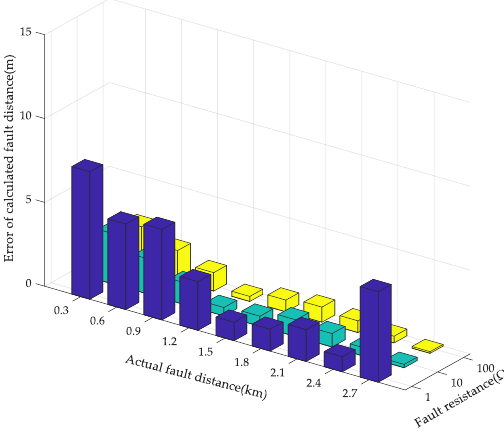
Figure 6. Error of computed fault distance for a-b-g fault on PT section.